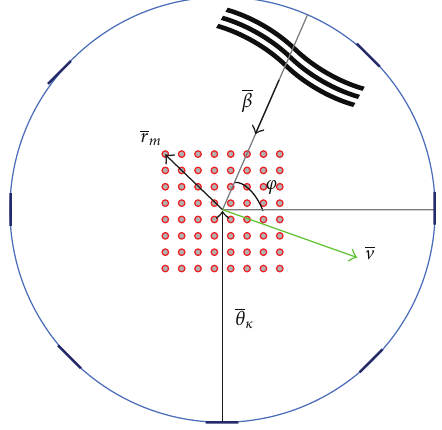
Figure 4: A single plane wave from AoA ϕ observed in location r m